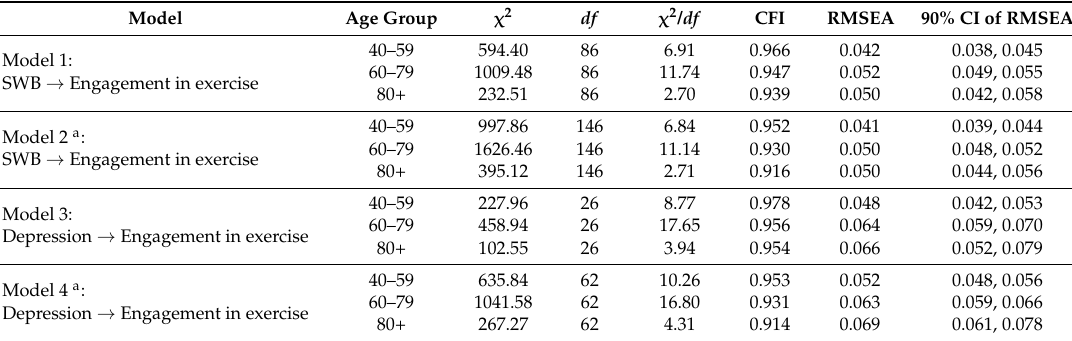
Table 5. Model Fit Indices for Mediation Analyses across